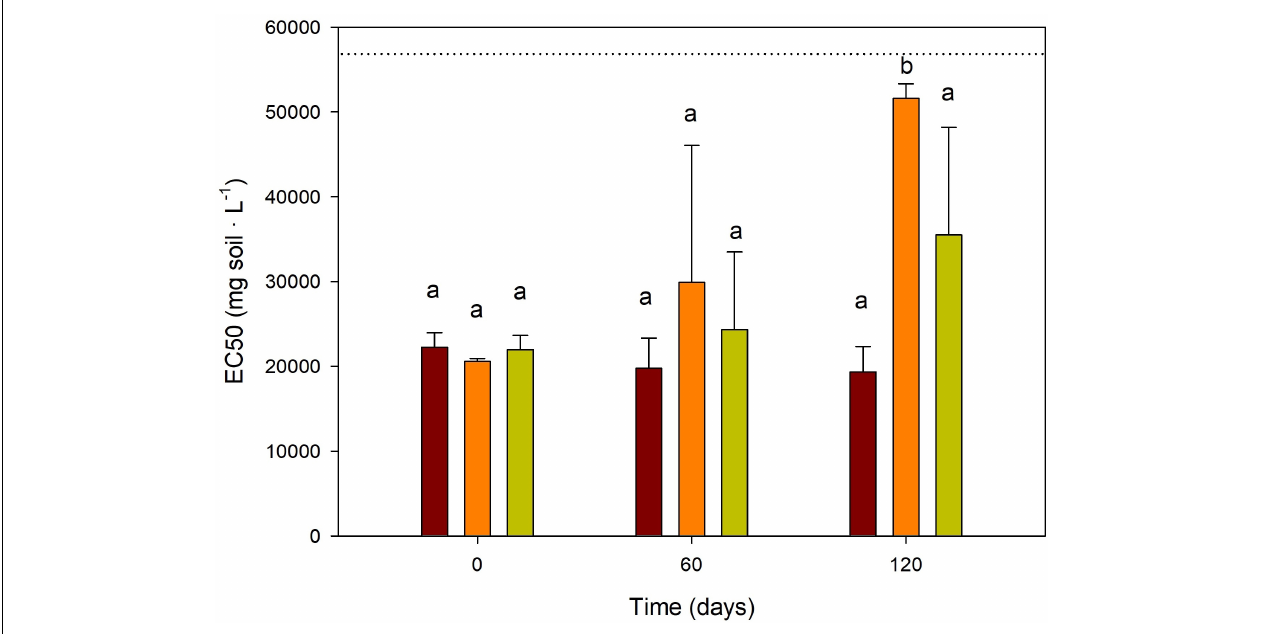
FIGURE 4 | Microtox ecotoxicity solid phase assays of soil (EC50 values expressed as mg soil L − 1 ) in the different treatments over 120 days of incubation. Dotted line represents EC value of clean soil (56,682 mg L − 1 ) collected in the vicinity of polluted site. Brown bar: contaminated control soil; Orange Bar Bioaugmentation; Green Bar (Biostimulation). Different lower-case letters within treatments indicate the occurrence of significant differences between them ( P < 0.05).